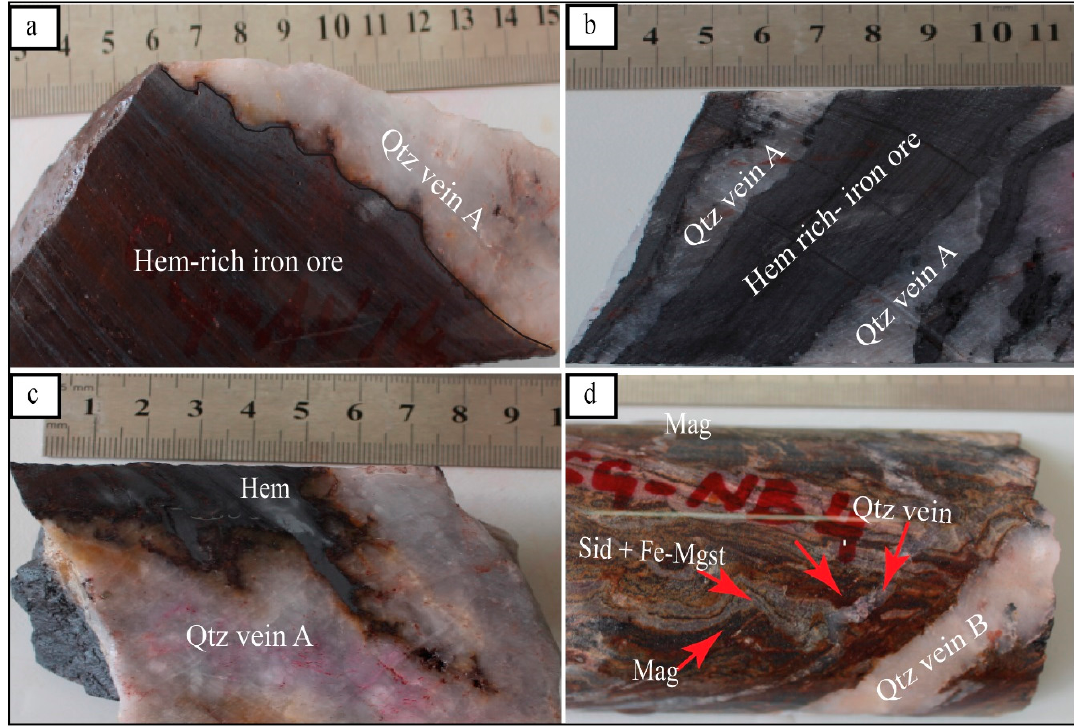
Figure 8. Hand-specimen photos of the Nabeba iron ores associated with quartz vein. ( a ) Quartz vein controlled by S0 microbedding oblique to hypogene high-grade iron (HO-1 stage); ( b, c ) quartz vein B concordant with the hematite high-grade iron ore (HO-1 stage); ( d ) quartz veins crosscutting and concordant with the magnetite-rich ore (HO-2 stage). Abbreviations: Qtz, quartz; Mag, magnetite; Sid, siderite; Fe-Mgst, ferroan-magnesite; Hem, hematite.